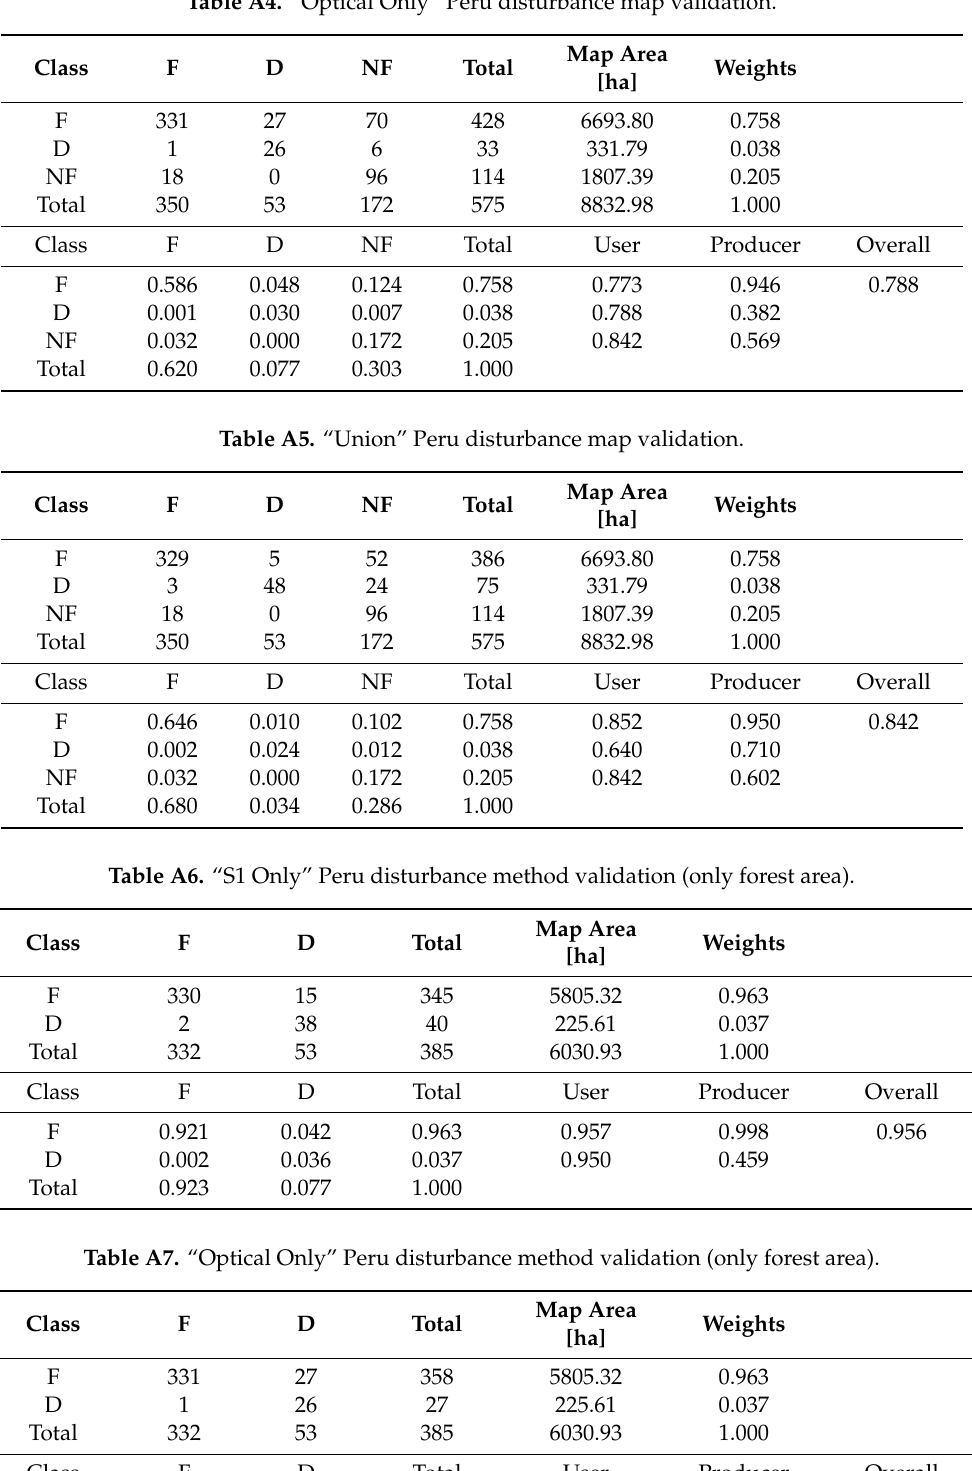
Table A4. “Optical Only” Peru disturbance map validation.